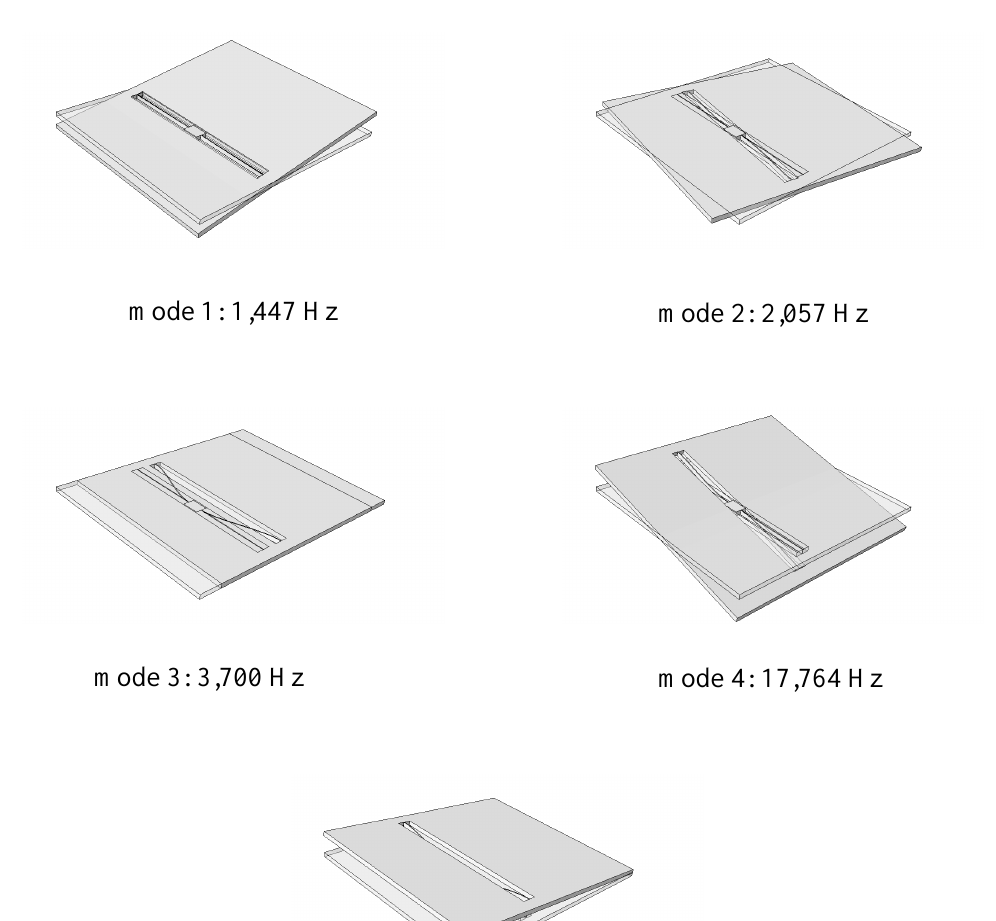
Figure 2. First five vibration modes of the uni-axial accelerometer, and relevant resonance